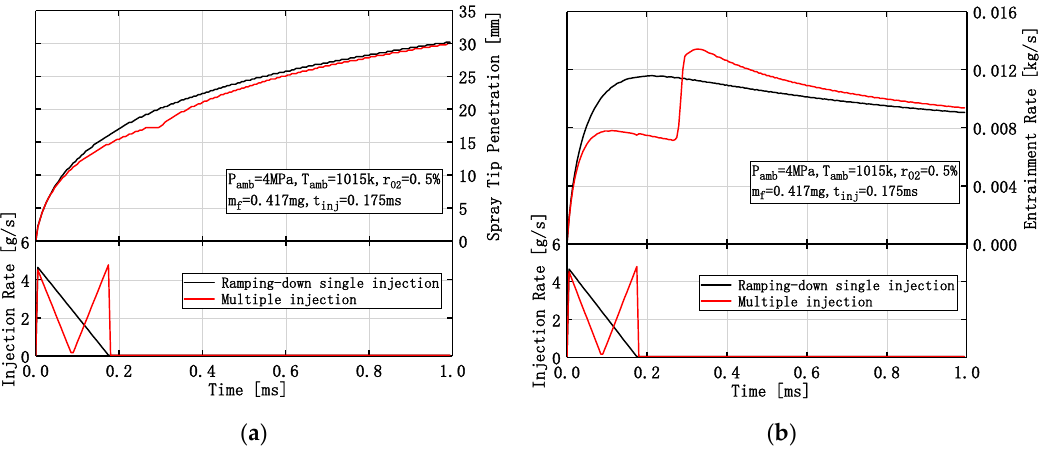
Figure 9. Comparisons of spray tip penetration ( a ) and entrainment rate ( b ) between the ramping-down single injection and the multiple-injection.